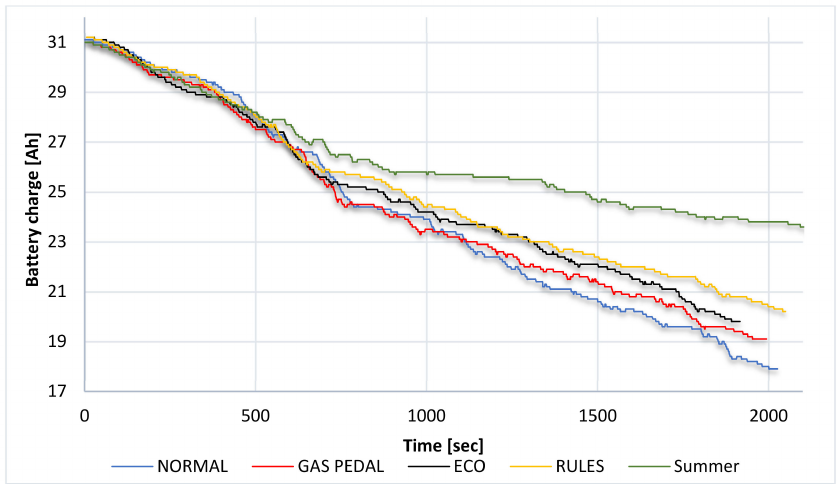
Figure 4. Battery capacity changes in “eco”